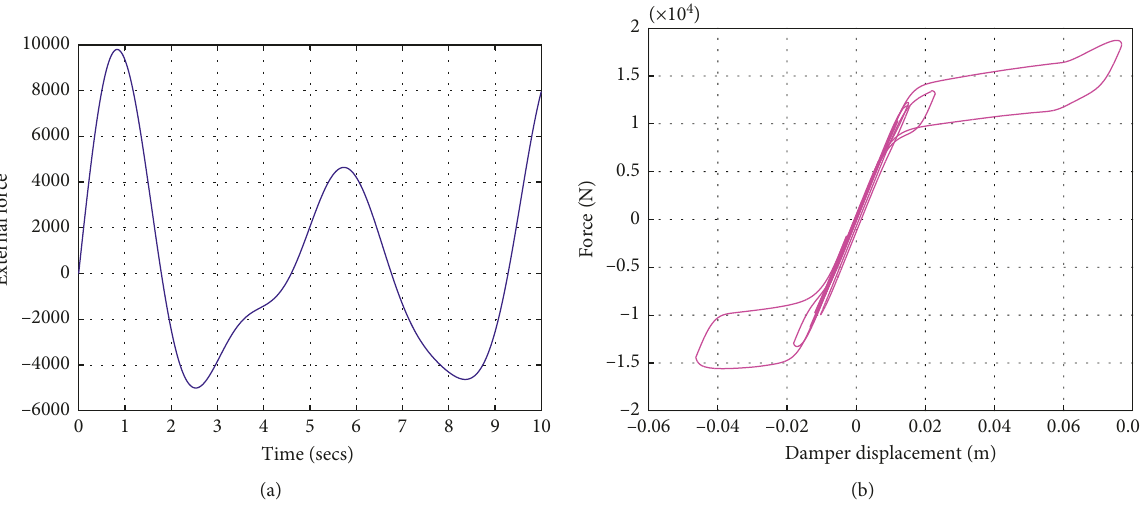
Figure 15: Random load followed by free vibration. (a) The external force applied and (b) the damper